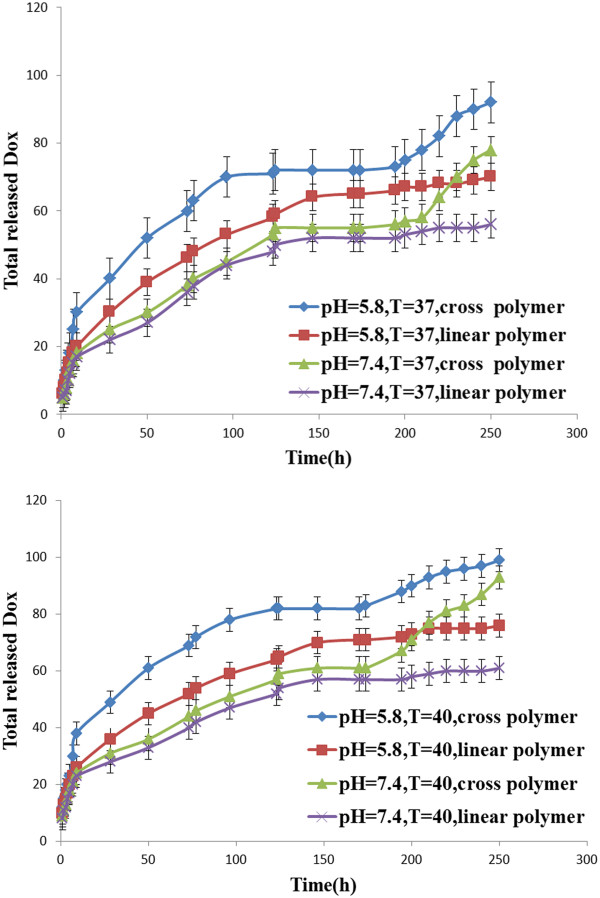
Release profiles of doxorubicin from the hybrid nanoparticles at different pH /temperature values.